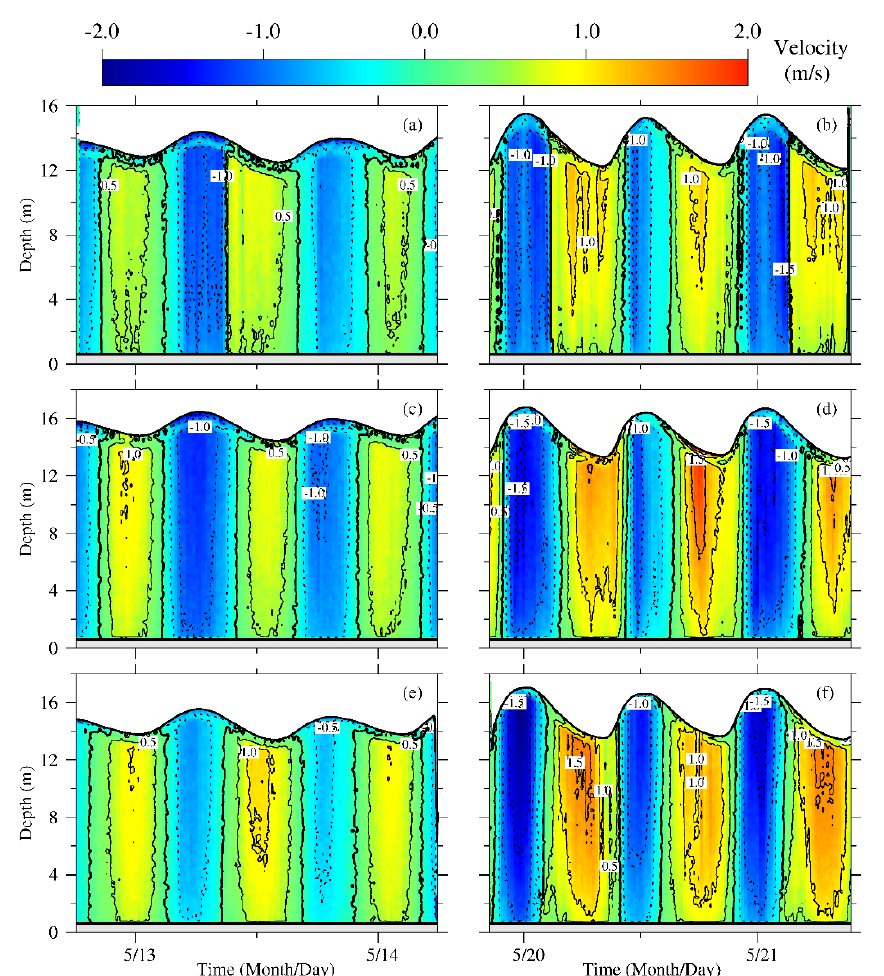
Figure 3. Current profiles (ebb current: positive, flood current: negative) at measurement sites A ( a , b ), B ( c , d ) and C ( e , f ) during the neap tide (left panels) and the spring tide (right panels).